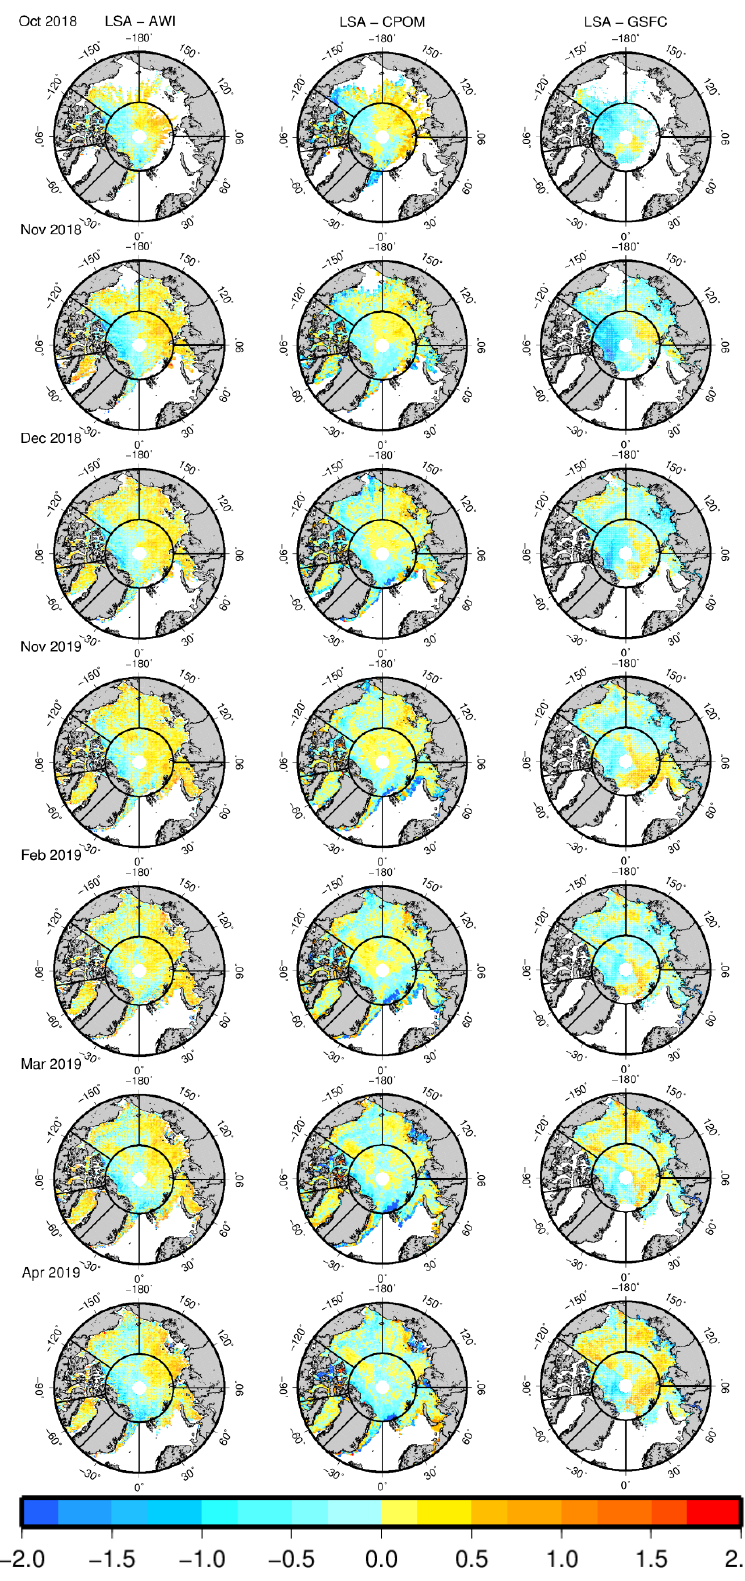
Figure 8. Distributions of sea ice thickness bias between the LSA and three CryoSat-2 thickness products for the 2018–2019 Arctic sea ice growth season from October to April; the left column indicates the LSA minus AWI (on 25 km grids); the middle column indicates the LSA minus CPOM (on 5 km grids); and the right column indicates the LSA minus GSFC (on 25 km grids). The bias distributions are presented for seven regions.